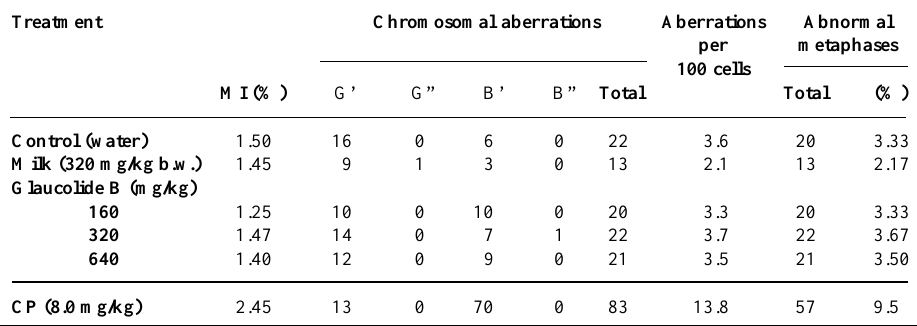
Table III - The mitotic index (MI) and the number and frequency of chromosomal aberrations and abnormal metaphases in bone marrow cells from BALB/c mice treated by gavage with glaucolide B.